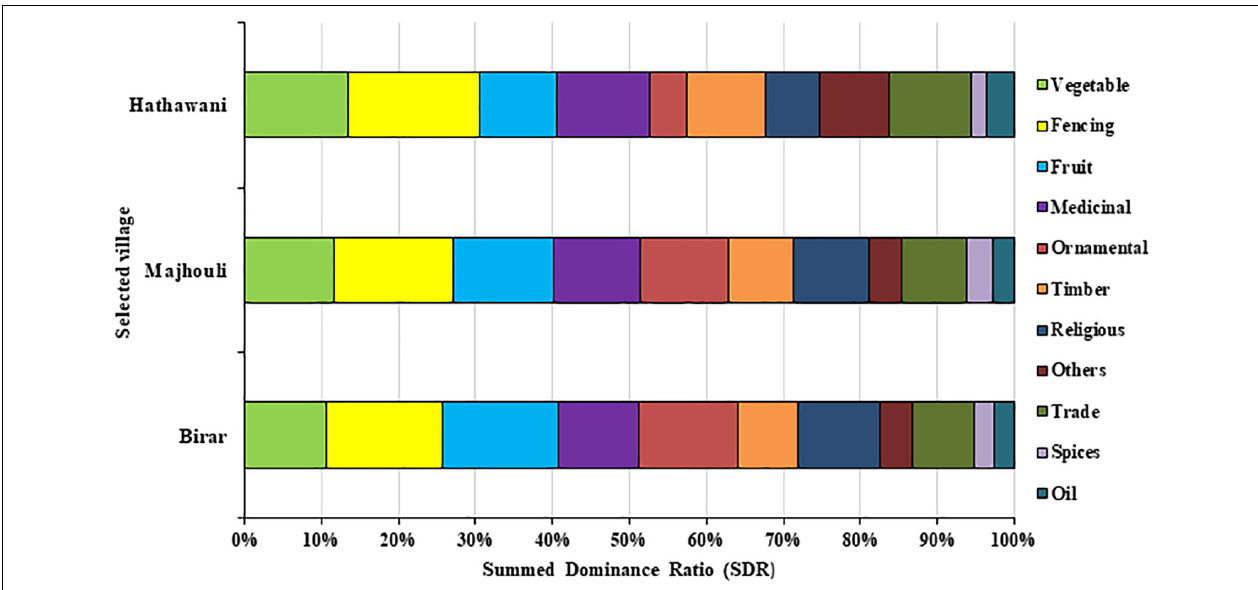
FIGURE 7 | The proportion of plant use in different use categories was estimated with Summed Dominance Ratio (SDR) for 133 plant species of 20 home gardens in three selected villages.